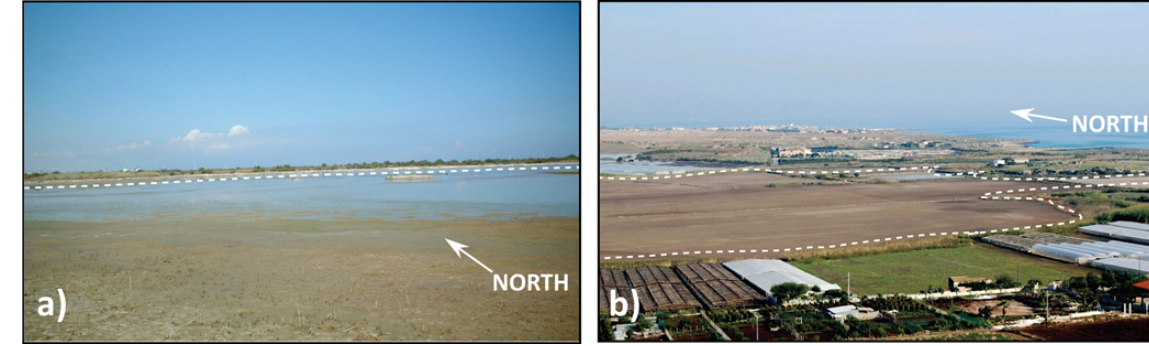
Fig. 4. View of the Priolo (a) and Morghella (b) sites, the white dashed line marks the edges of the almost flat